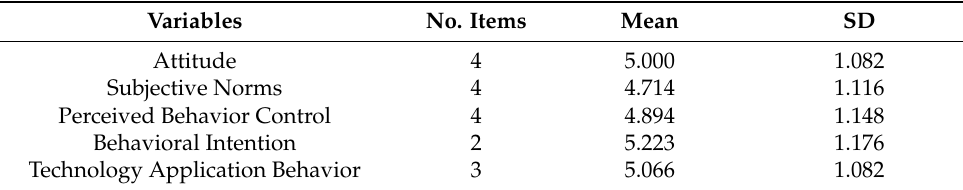
Table 2. Descriptive